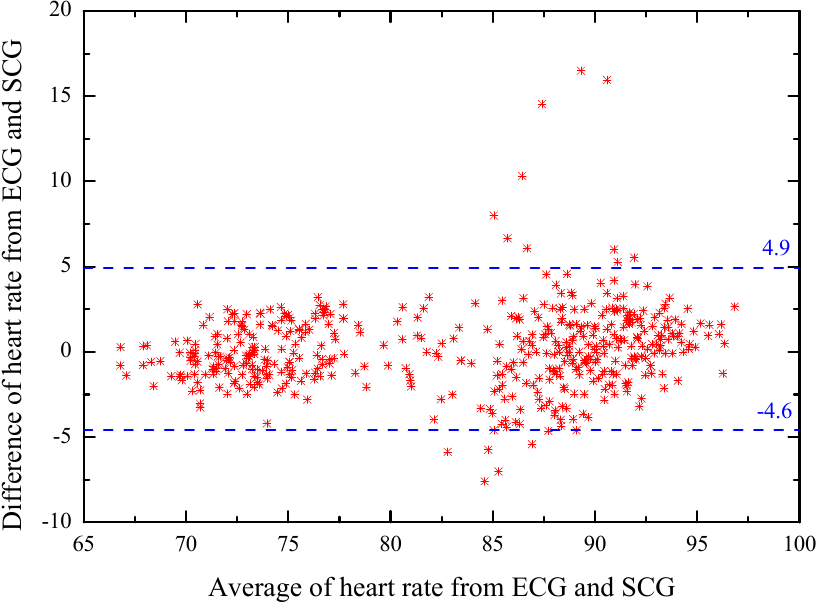
Figure 13. Bland–Altman plot of the heart rate measurements from ECG and SCG.